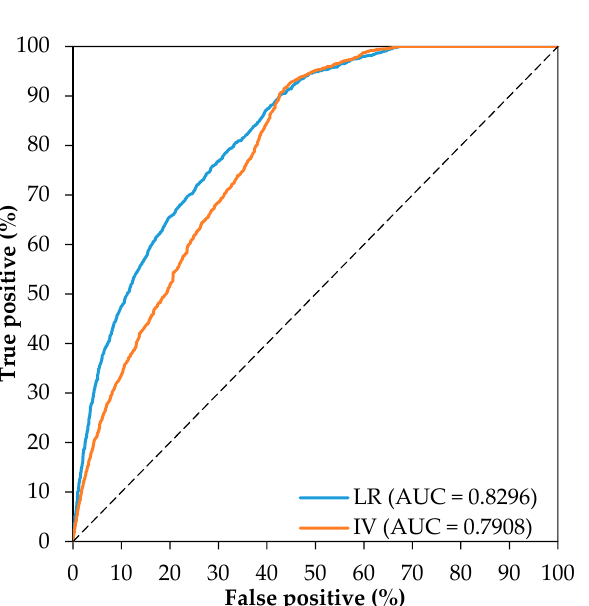
Figure 5. Receiver operating characteristic (ROC) curves for the models with all factors, produced with the corresponding areas under the curve (AUC). In blue, logistic regression (LR) and in red, information value (IV).